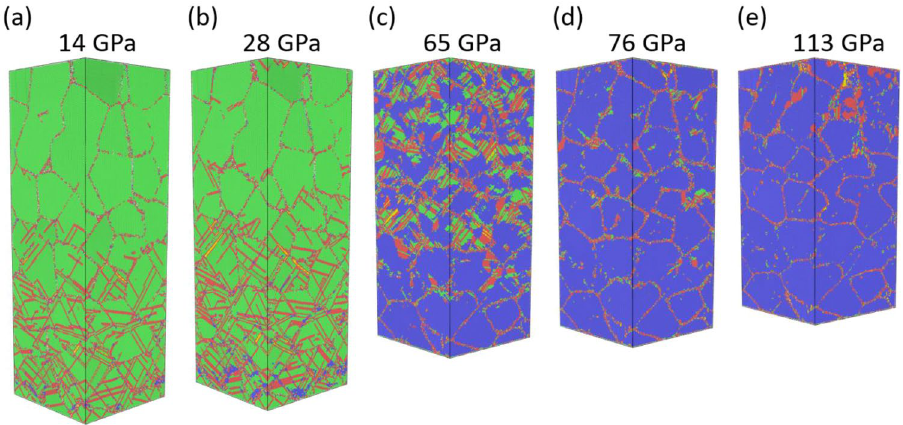
Figure 6. Atomistic snapshot of the texturized NC Al at different global stress. Atoms are colored in the same manner as Fig. 2. The loading direction is from bottom to